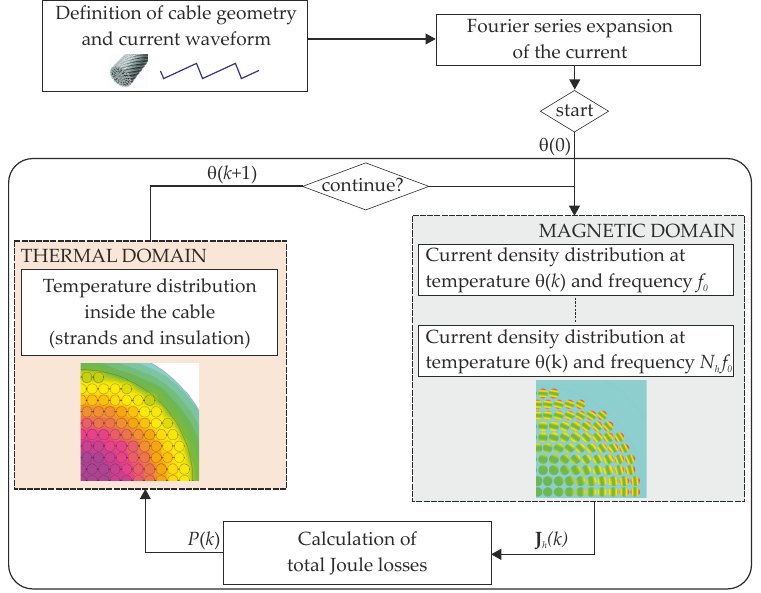
Figure 5. Flowchart for cross-coupled numerical evaluation of the cable thermal transient evolution.